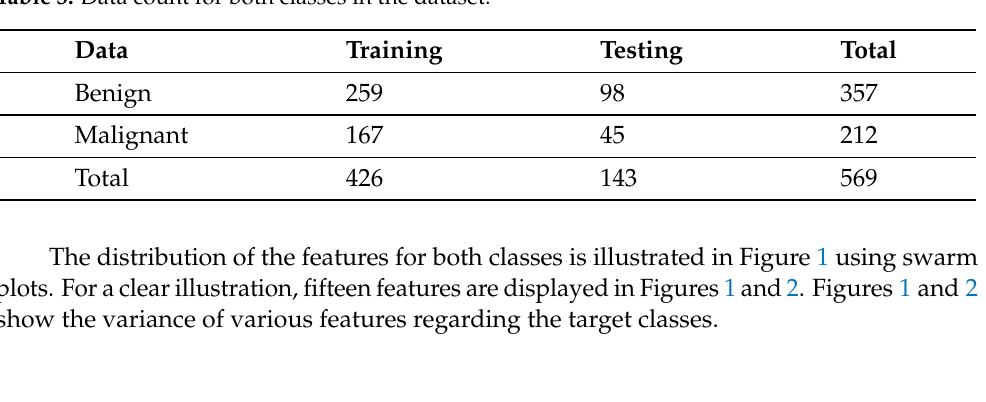
Table 3. Data count for both classes in the